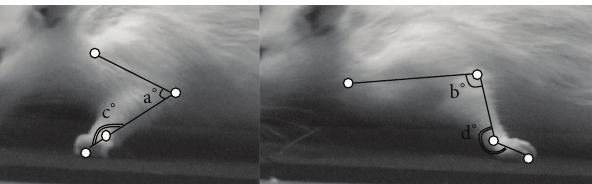
Figure 3: Range of motion (elbow: a–b ∘ ; wrist: c–d ∘